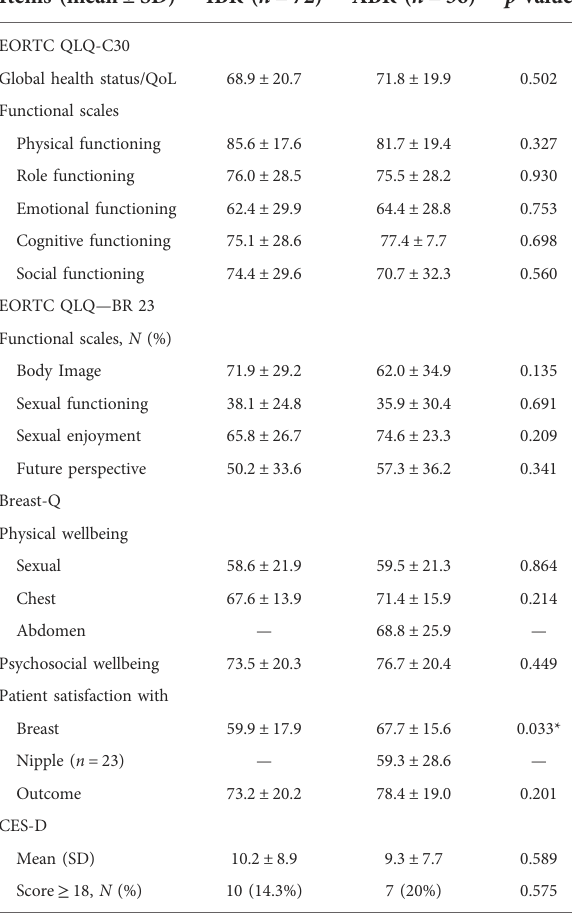
TABLE 5 EORTC QLQ-C30 and QLQ-BR23 scores in all patients undergoing skin- or nipple-sparing mastectomy. Items (mean ±